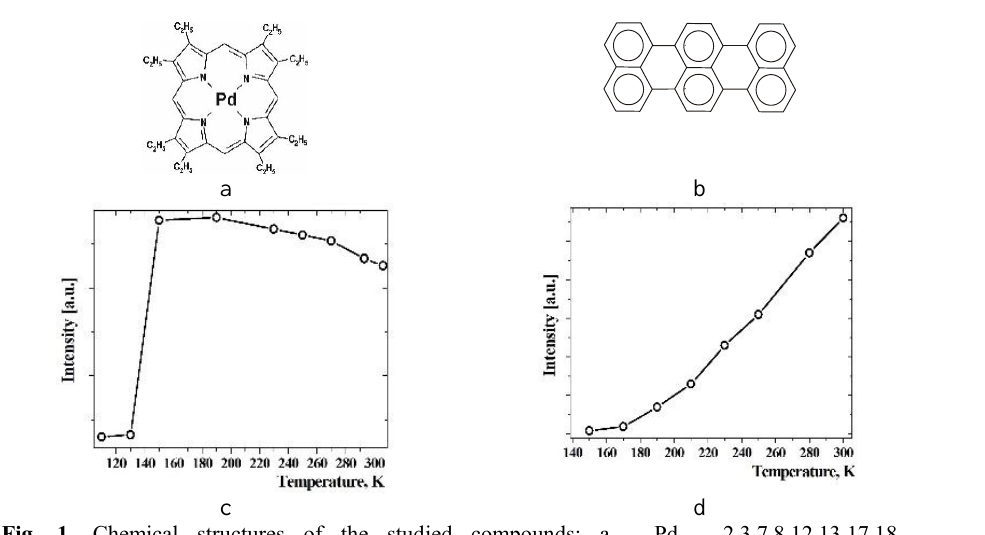
Fig. 1. Chemical structures of the studied compounds: a - Pd - 2,3,7,8,12,13,17,18 - octaethylporphyrin (Pd-OEP); b - terrylene (TER), as well as the temperature dependence of the efficiency of singlet oxygen generation for Pd-ОEP ( c) and TER (d) in